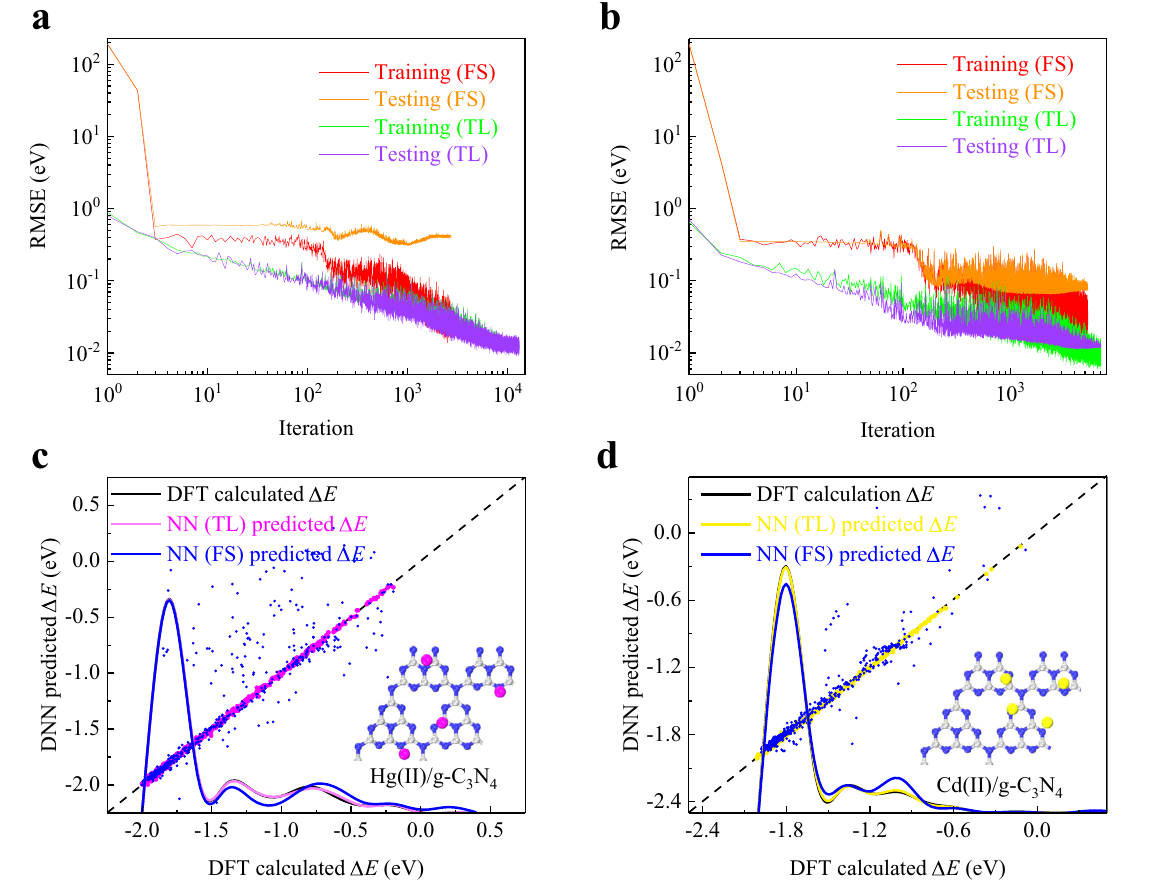
Fig. 4 Performance of the model trained from scratch (FS) and transfer learning (TL). a The training and testing RMSE of Hg(II)/g-C 3 N 4 as a function of iteration. b The training and testing RMSE of Cd(II)/g-C 3 N 4 as a function of iteration. c , d The correlation plots of Δ E of Hg(II)/g-C 3 N 4 (c) and Cd(II)/g-C 3 N 4 (d) between DFT calculations and DNN predictions (FS and TL), along with histograms of predicted and calculated energy distributions.